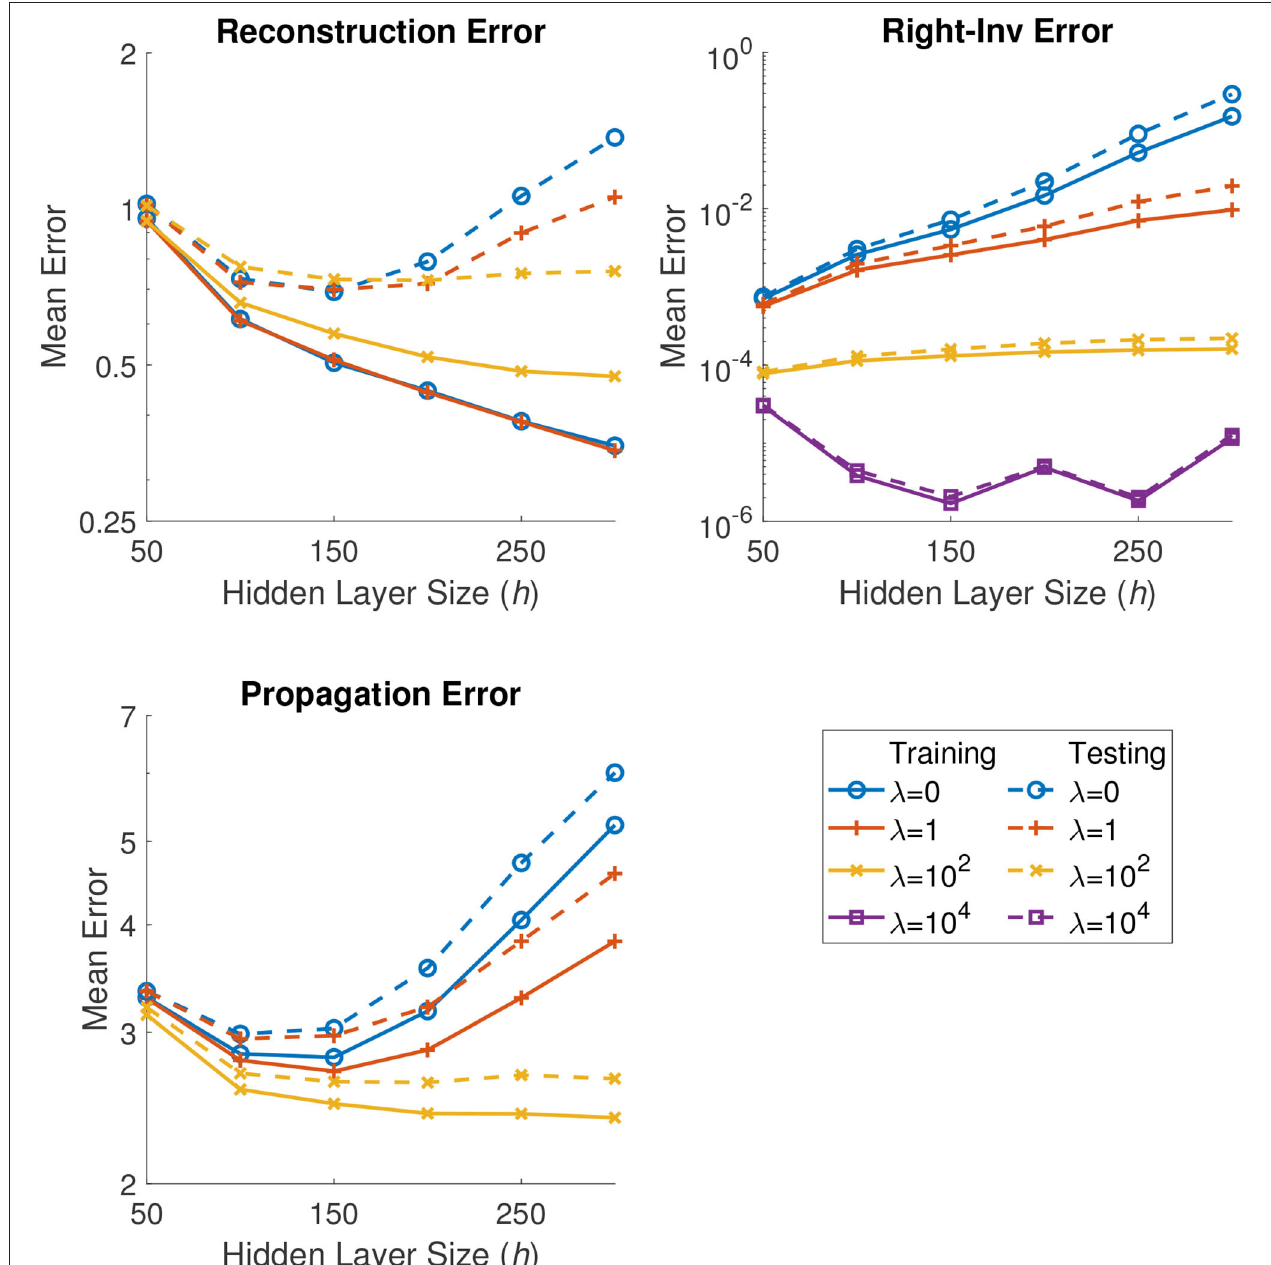
FIGURE 2 | Results for an autoencoder-based ROM of dimension r = 28 approximating the Lorenz’96 FOM. The figure illustrates the mean error for the three error types that we observe: reconstruction error (80), the right invertibility error (81), and the propagation error (82), on both the training and testing data sets.